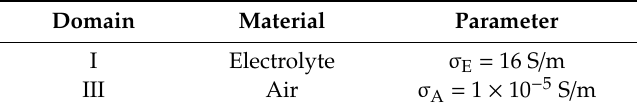
Table 2. Material definitions for the simulations of electrodynamics.